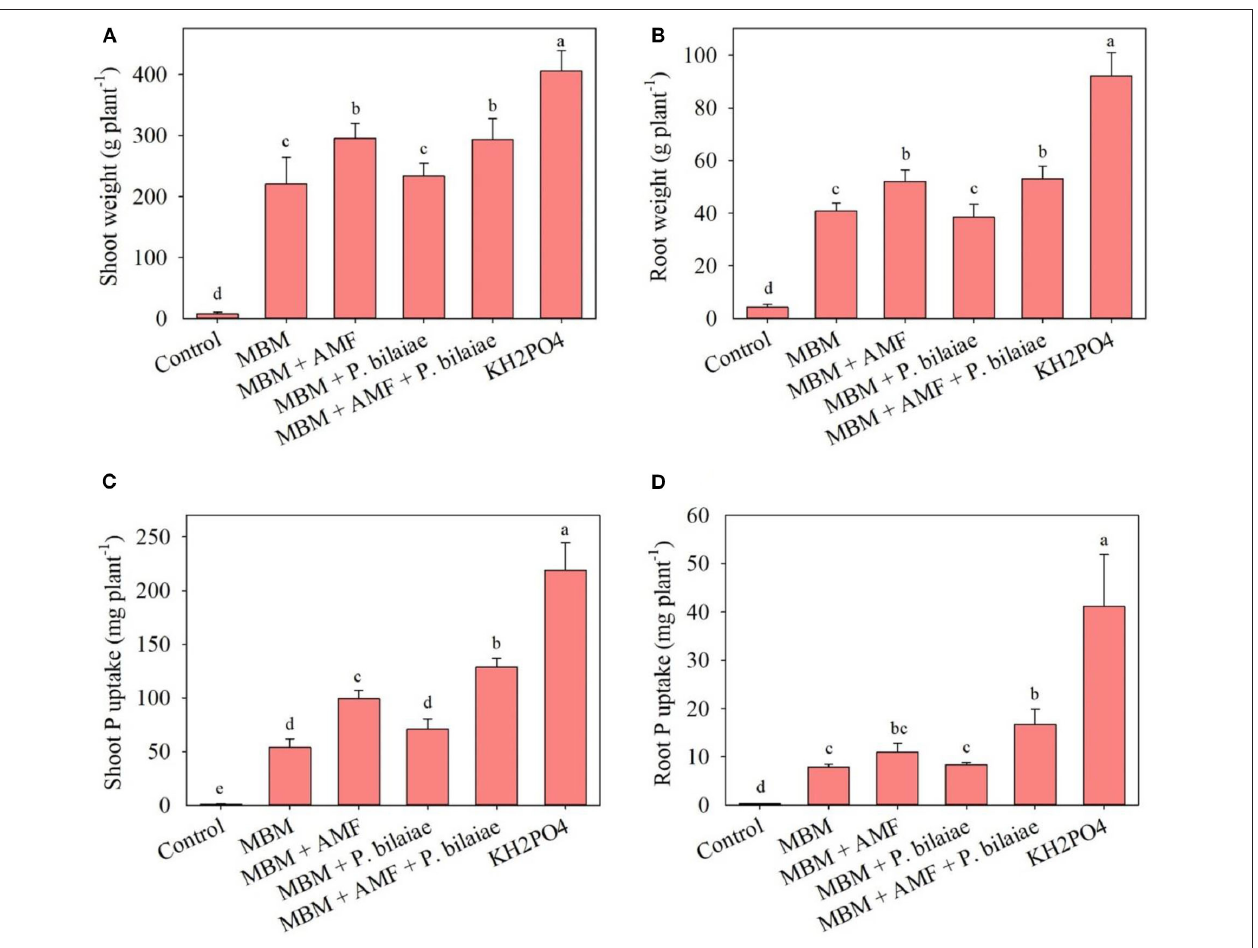
FIGURE 3 | Plant shoot (A) , root biomass (B) , shoot P (C) , and root P uptake (D) as affected by different P fertilizers and P mobilizers (arbuscular mycorrhizae fungi (AMF) and P. bilaiae ) at 40 days after planting. Different alphabetical letters signify the statistical difference (Tukey test, p < 0.05) across the treatments. Error bar represents the mean ± SD ( n =